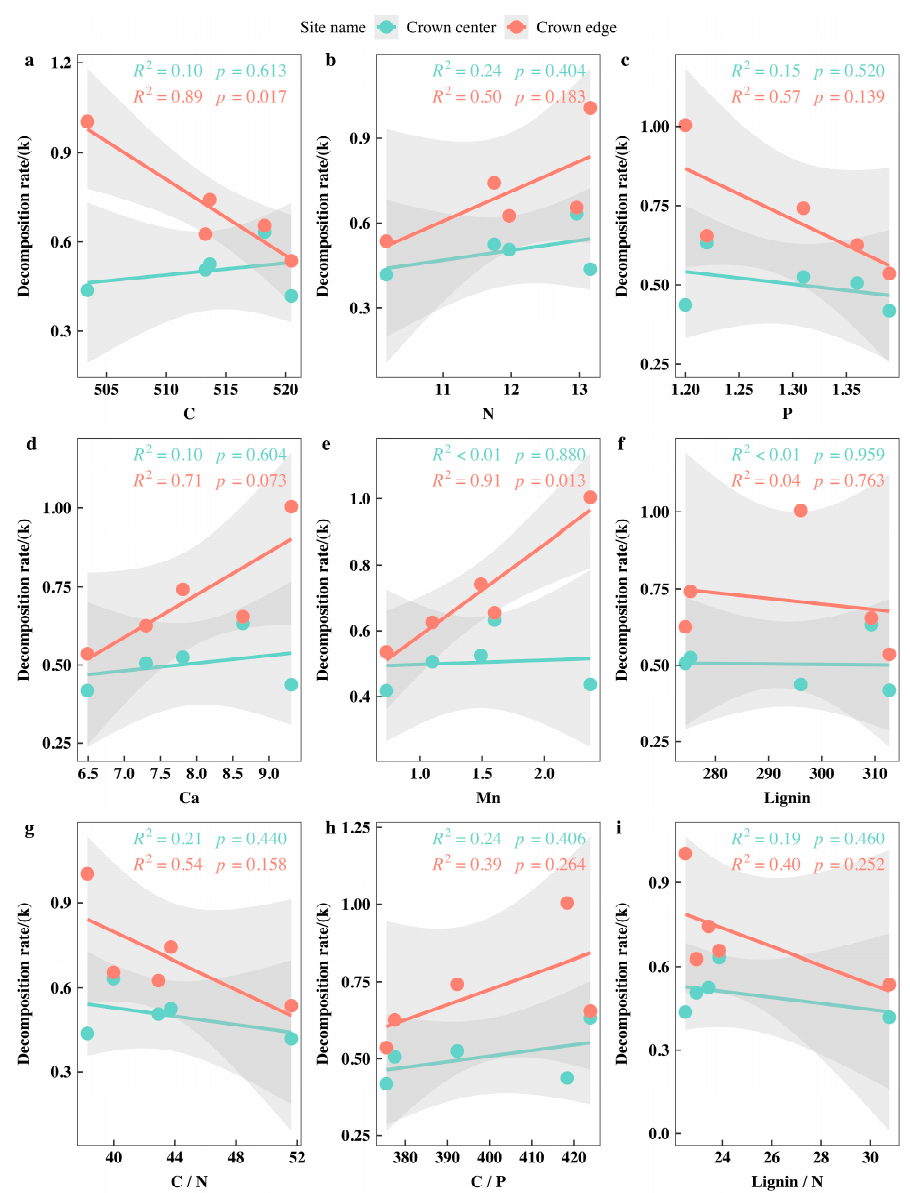
Figure 12. Relationships between the initial concentrations of some major nutrients, lignin, and eco- stoichiometric ratios in leaf litter (mg · g − 1 DM) taken from different altitude CC and CE of Qinghai spruce sites shown with the initial decomposition rate ( k ). ( a ) The relationship between C concentra- tion and the initial decomposition rate of litter. ( b ) The relationship between N concentration and the initial decomposition rate of litter. ( c ) The relationship between P concentration and the initial decomposition rate of litter. ( d ) The relationship between Ca concentration and the initial decom- position rate of litter. ( e ) The relationship between Mn concentration and the initial decomposition rate of litter. ( f ) The relationship between lignin concentration and the initial decomposition rate of litter. ( g ) The relationship between eco-stoichiometric ratio C/N and the initial decomposition rate of litter. ( h ) The relationship between eco-stoichiometric ratio C/P and the initial decomposition rate of litter. ( i ) The relationship between eco-stoichiometric ratio lignin/N and the initial decomposition rate of